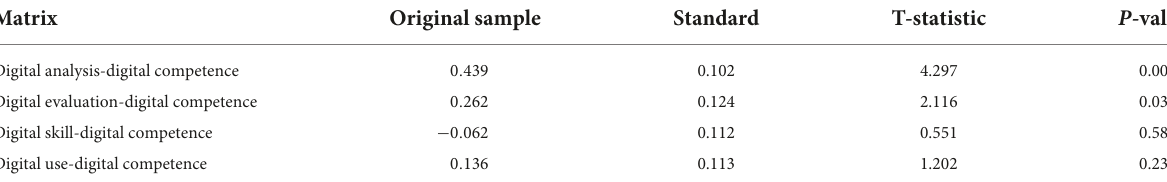
TABLE 3 Path analysis test results.